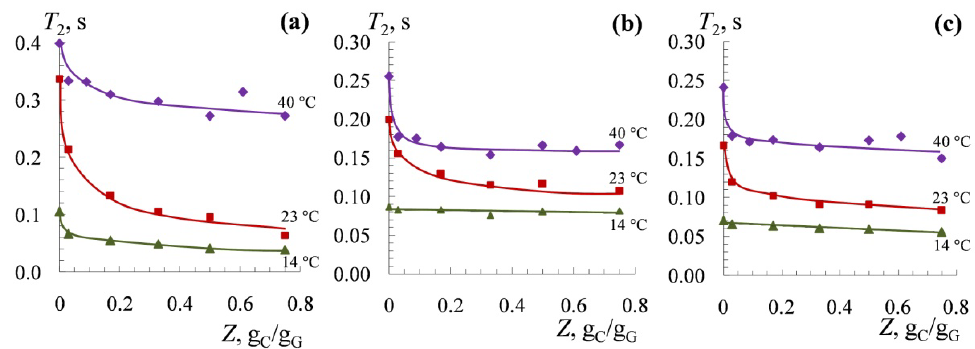
Figure 5. Spin‐spin (transverse) relaxation times T 2 for the protons of gelatin groups of Lys ε ‐CH 2 ( a ); Val , Leu , and Ile γ ‐CH 3 ( b ); and Hyp β ‐CH 2 ( c ) in gelatin in 99.8% D 2 O at the κ ‐carrageenan/gelatin w / w ratio Z , g C /g G and at different temperatures. Original figure. A t 23 °С, an increase in the mass ratio of the biopolymers to Z = 0.75 g C /g G leads to a